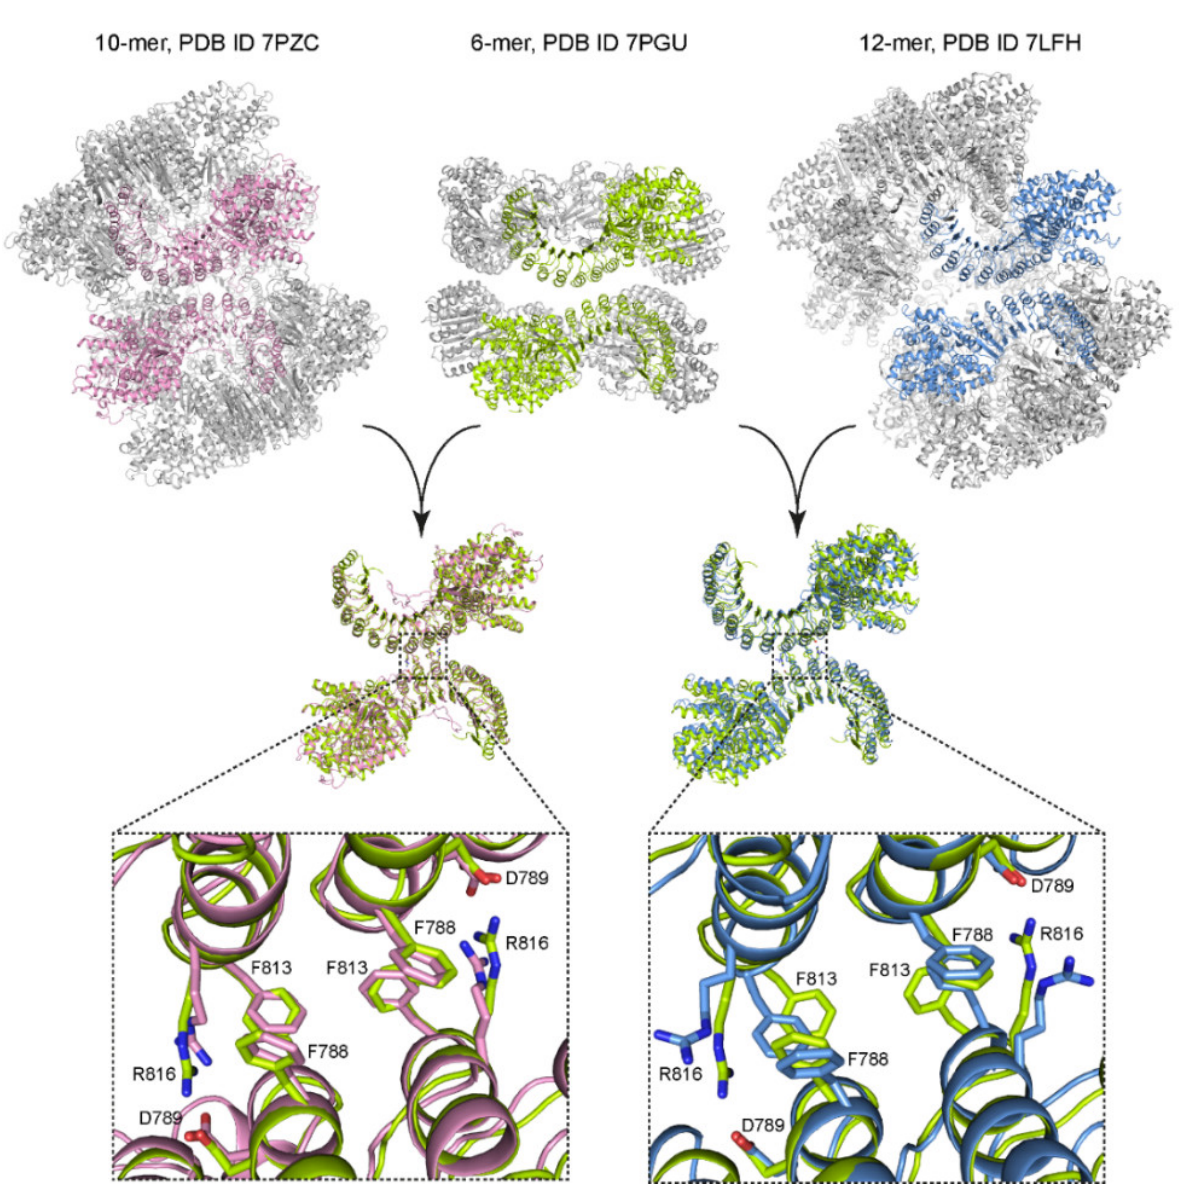
Figure 2. Comparison of experimental structures of complexes of NLRP3. Shown in the top row are cartoon representations of decameric ( left ) and dodecameric ( right ) complexes of full-length NLRP3 as well as of a hexameric complex of PYD-deleted NLRP3. Superpositions of back-to-back dimers from the decamer and the dodecamer with the hexamer (as indicated by the arrows) are shown in the middle row. The bottom row shows magnified views on the dimer interfaces from the superpositions. Amino acids involved in the interface are shown in stick representation and are labelled according to the sequence numbering of human NLRP3.